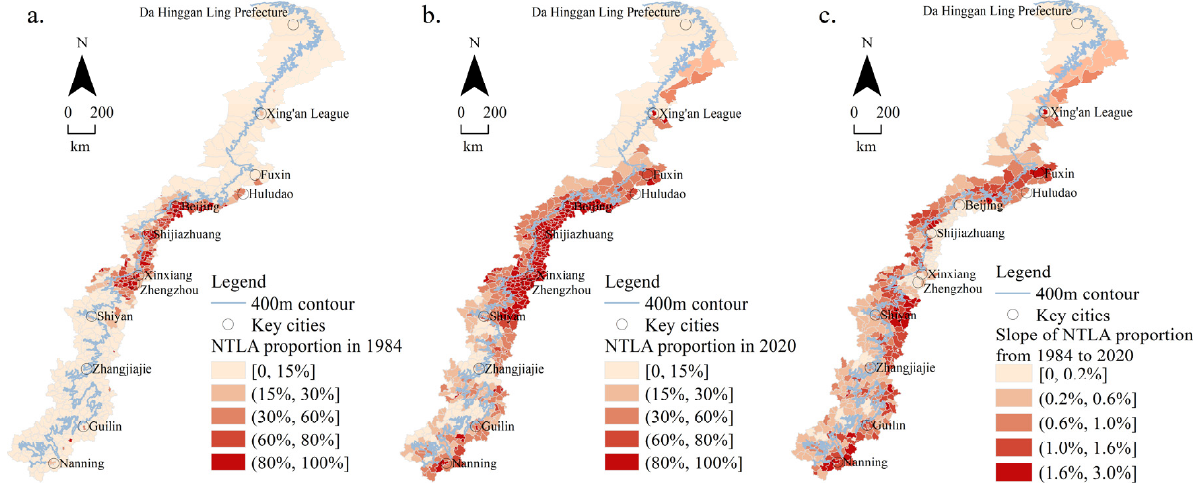
Figure 7. Nighttime lighting area proportions: ( a ) in 1984; ( b ) in 2020; ( c ) slope from 1984 to